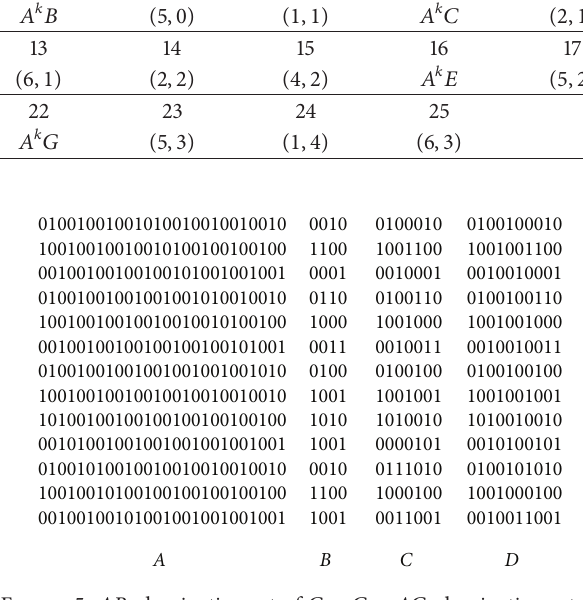
Figure 5: 𝐴𝐵 : dominating set of 𝐶 13 ◻𝐶 30 ; 𝐴𝐶 : dominating set of ◻𝐶 𝐴𝐷 : dominating set of 𝐶 𝐶 13 33 ;